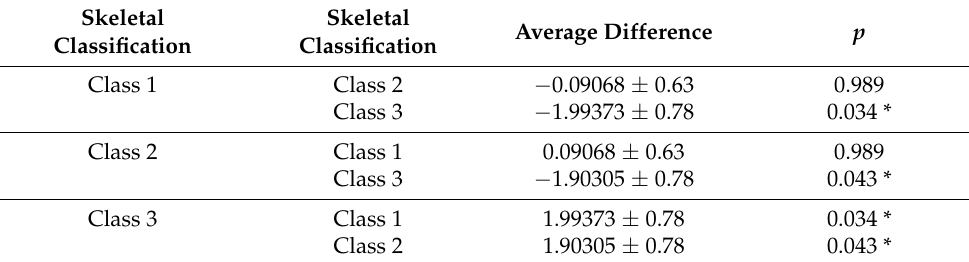
Table 4. Comparison of N-R distance between the skeletal malocclusions.